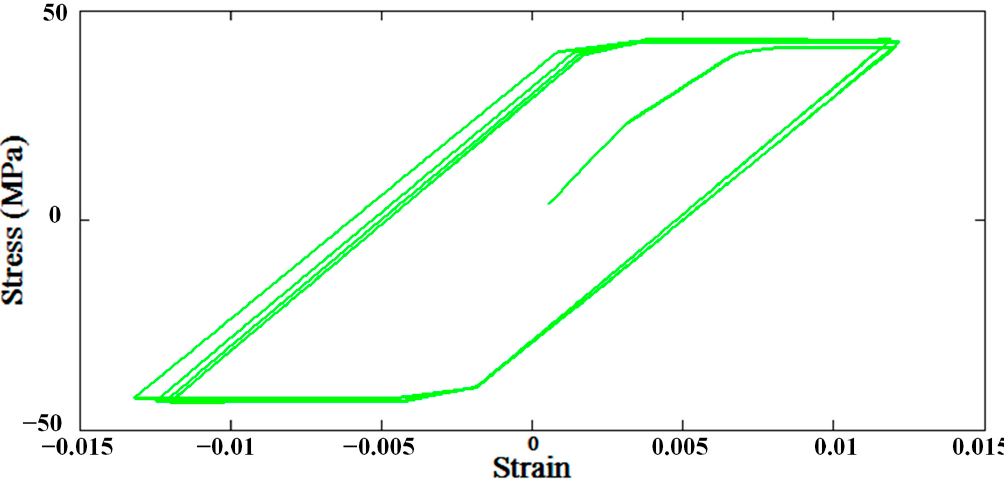
Figure 7. The hysteresis loop for 10 cycles and R = − 1.